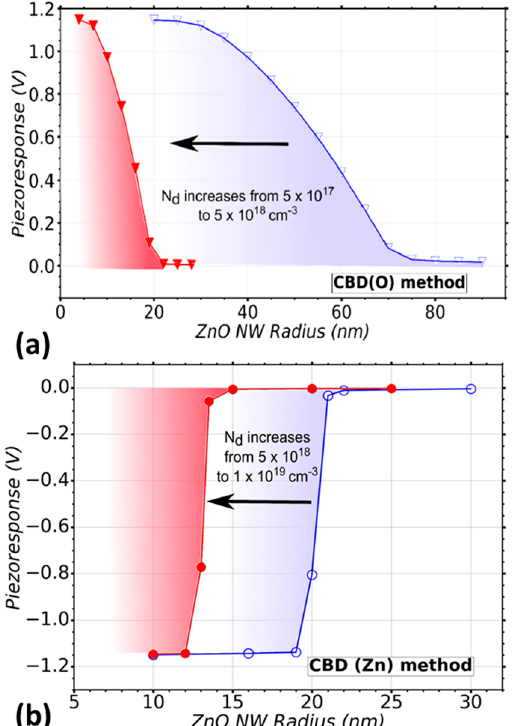
Figure 6. Variation of the piezoresponse of a VING as a function of ZnO NW radius taking into account the CBD deposition technique. ( a ) A range of doping level (N d ) from 5 × 10 17 (